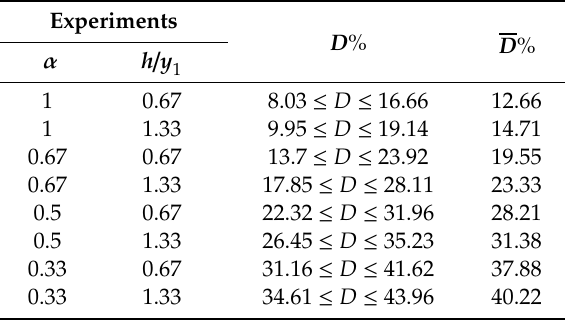
Table 2. The range and mean reduction of sequent depth ( 𝐷 %).